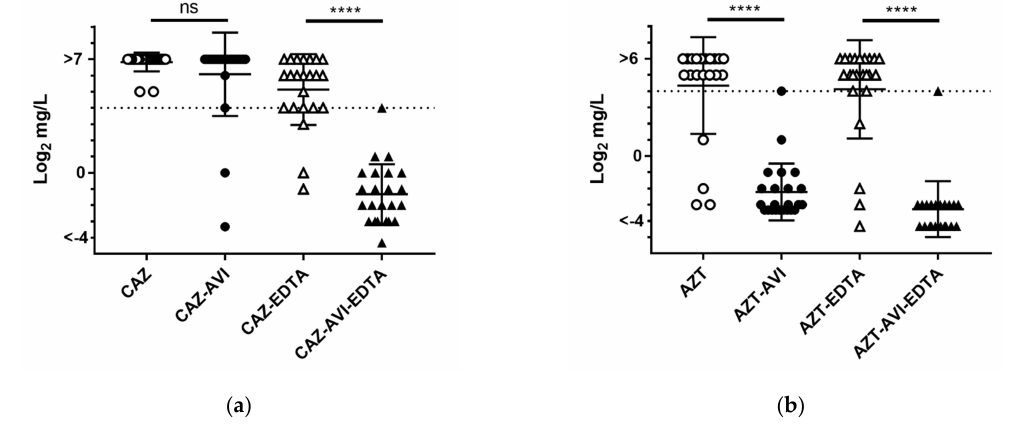
Figure 5. MIC distributions of (a) ceftazidime (hollow circles) and (b) aztreonam (hollow circles) and their respective combination therapies (filled circles) following the addition of EDTA (triangles). Abbreviations: CAZ, ceftazidime; CAZ-AVI, ceftazidime with avibactam; AZT, aztreonam; AZT-AVI, aztreonam with avibactam. ns, no statistical significance; ****, p < 0.0001.